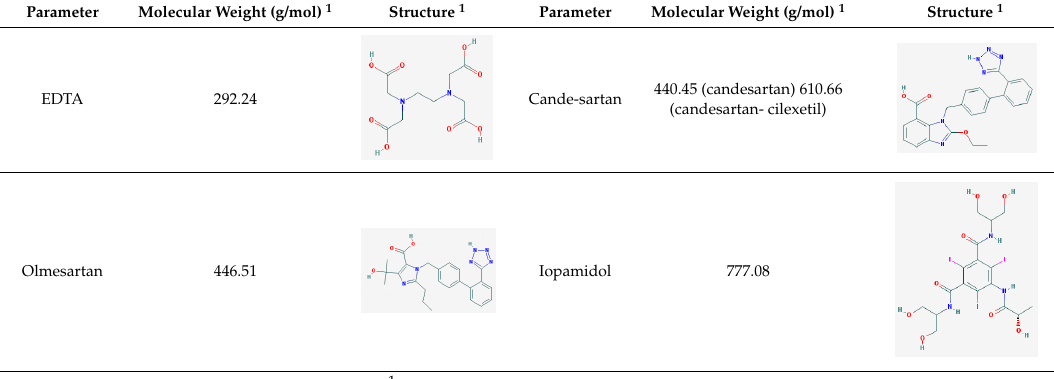
18 of 22 Table A4. Analyzed organic micropollutants, molecular weight, structure. Parameter